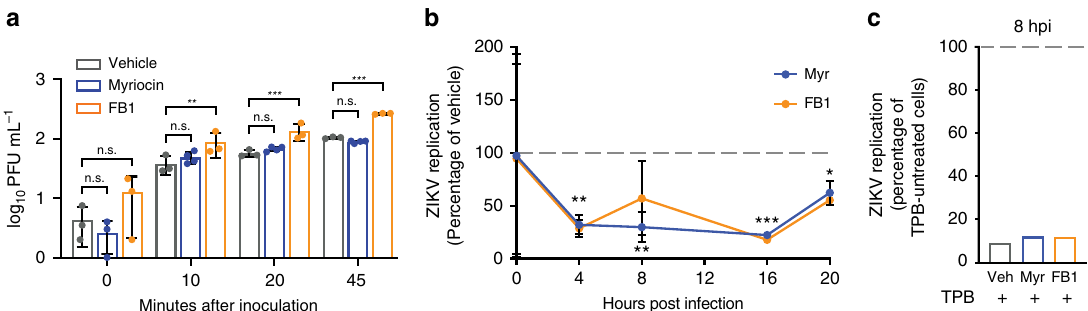
Fig. 4 Sphingolipids are required for ZIKV replication. a Monolayers of Vero cells pretreated for 3 days with myriocin, FB1, or a vehicle control were incubated on ice for the indicated times with 100 PFUs before washing and overlay with media without the inhibitors. Plaques were counted after 3 days. Data are representative of four independent experiments. Two-way ANOVA with Tukey ’ s multiple-comparison test. b Huh7 cells pretreated for 3 days with myriocin, FB1, or a vehicle control were infected with ZIKV (MOI = 20). Intracellular ZIKV replication in myriocin or FB1-treated cells was measured at the timepoints shown and plotted relative to vehicle. n = 3 independent experiments. n = 4 independent experiments. c Huh7 cells treated with inhibitors as in ( b ) were pretreated for 24 h with the RNA polymerase inhibitor TPB, infected as before, then maintained in TPB and inhibitor/vehicle-treated media for 8 h. At 8 hpi, intracellular replication in TPB-treated cells was measured relative to non-TPB-treated cells for each condition. n = 2 independent experiments. Data are mean ± SD; n.s. not signi fi cant, * P < 0.05, ** P < 0.01, *** P < 0.001, two-tailed Student ’ s t test. See also the Source Data (Fig. 4c). ZIKV RNA in both sphingolipid-depleted and vehicle cells decreased by approximately tenfold under TPB treatment, ruling out a prereplication viral requirement for sphingolipids.